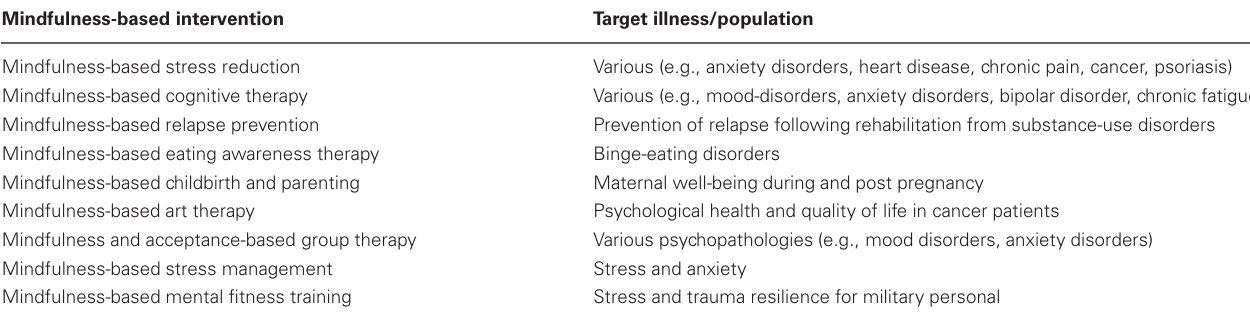
Table 1 | Sample of group-based MBIs along with target